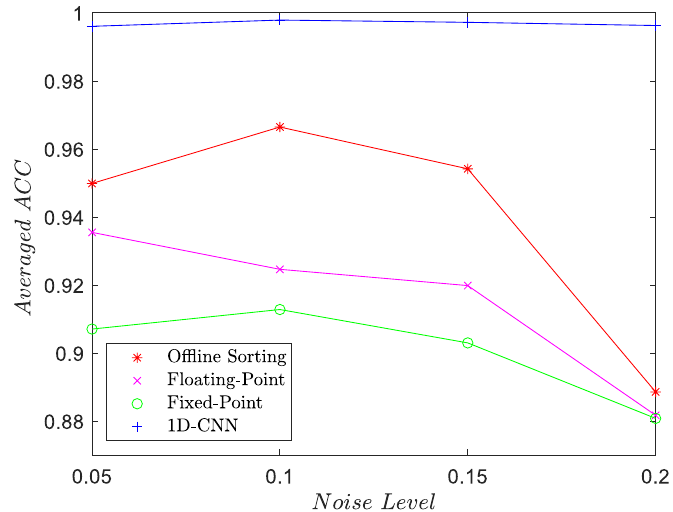
Figure 9. Comparison of floating-point and fixed-point implementation of our algorithm together with an offline sorting tool provided by [13] and a 1D-CNN model [17]. Table 5. Comparison with the state of the art.